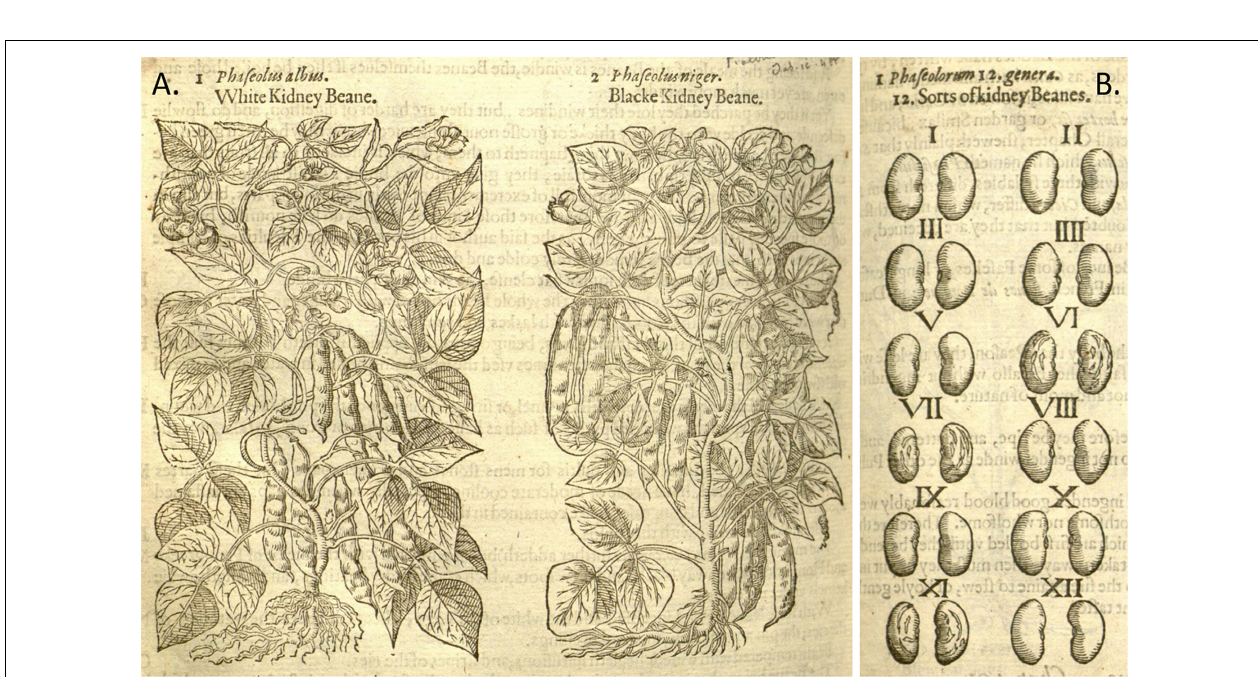
FIGURE 9 | Woodcuts of Phaseolus beans from Gerard’s (1597) Herbal . (A) Plate showing two common bean plants labeled White and Black Kidney. (B) Seeds of “kidney Beanes”. Source: Public domain; Biodiversity Heritage Library (Holding Institution: Missouri Botanical Garden, St. Louis, MO, United States).